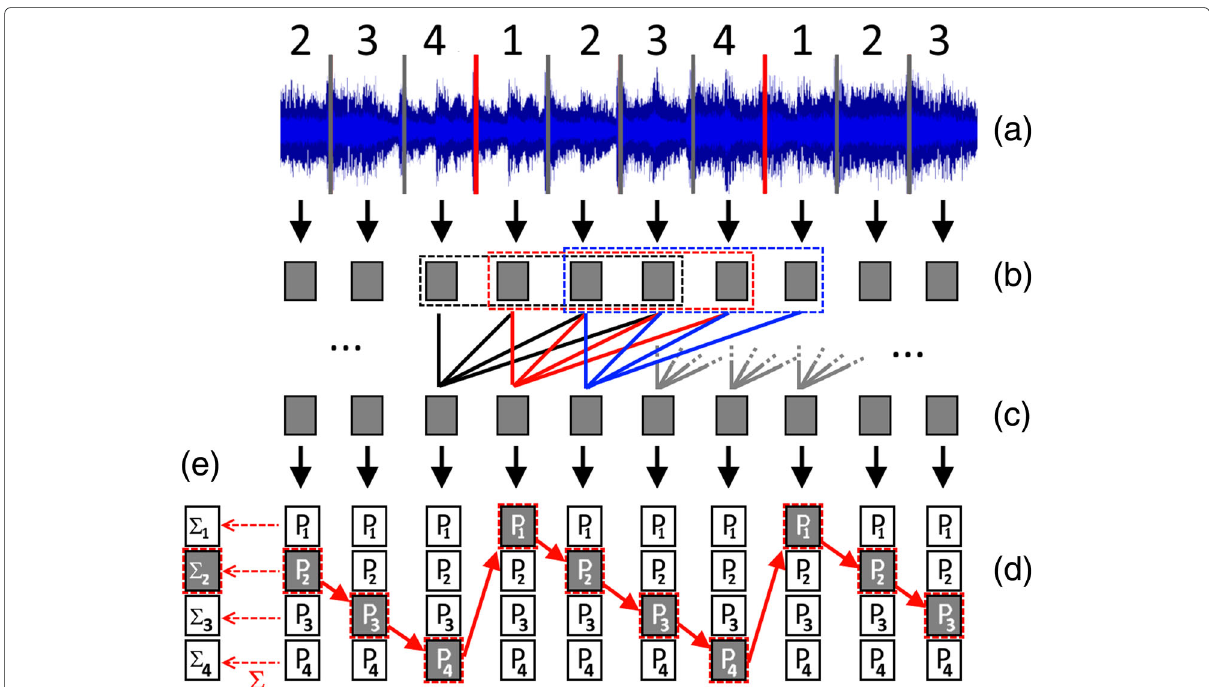
Fig. 4 Overview of the downbeat tracking algorithm. a The audio waveform, annotated with beats and downbeats. b Isolated features are extracted from the beats. c Isolated features are combined to create contextual features. d The machine learning model classifies each beat, estimating the log-probability of a beat being either the 1st, 2nd, 3rd, or 4th beat in a measure. e The downbeats are determined by summing the log-probabilities along each possible trajectory and choosing the most likely one. Here, the second trajectory is